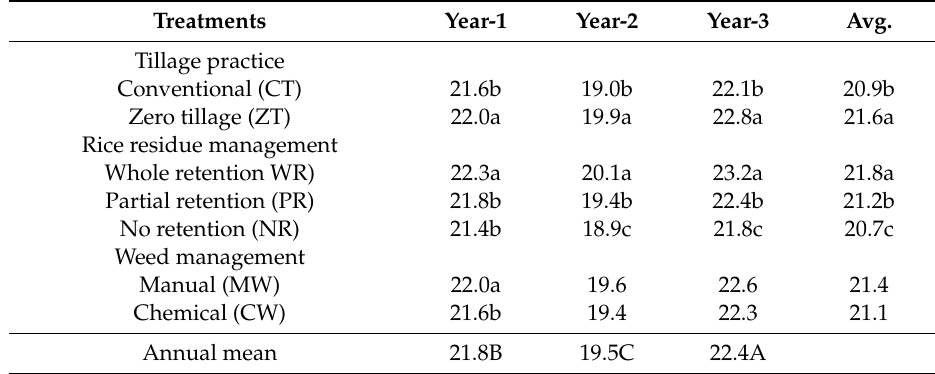
Table 5. Weight of 1000 grains of rice under di ff erent tillage, crop residue and weeding managements. Di ff erent lowercase letters within a column indicate significant di ff erence with a treatment. Di ff erent uppercase letter within a row for annual mean values (last row) indicate significant di ff erence among the study